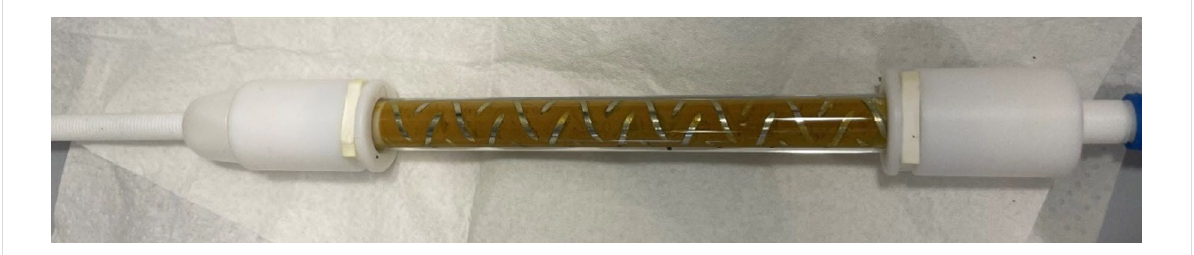
Figure 6: Photo of the packed column with a helical static mixer (polished SS316, 10 cm length, 15 mixing elements L/D = 1.04 from Stamixco AG).